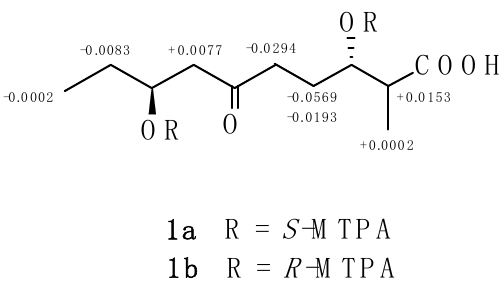
Figure 3. ∆ δ values ( ∆ δ = δ S − δ R ) around C-3 and C-8 obtained from 1a and 1b . Figure 3. Δδ values ( Δδ = δ S − δ R ) around C-3 and C-8 obtained from 1a and 1b. Six previously reported compounds, nonactic acid ( 2 ), homononactic acid ( 3 ), ethyl homononactate ( 4 ), homononactyl homononactate ( 5 ), valinomycin ( 6 ), cyclo-(Pro-Leu) ( 7 ), were also isolated from the combined mycelial and culture broth extract of